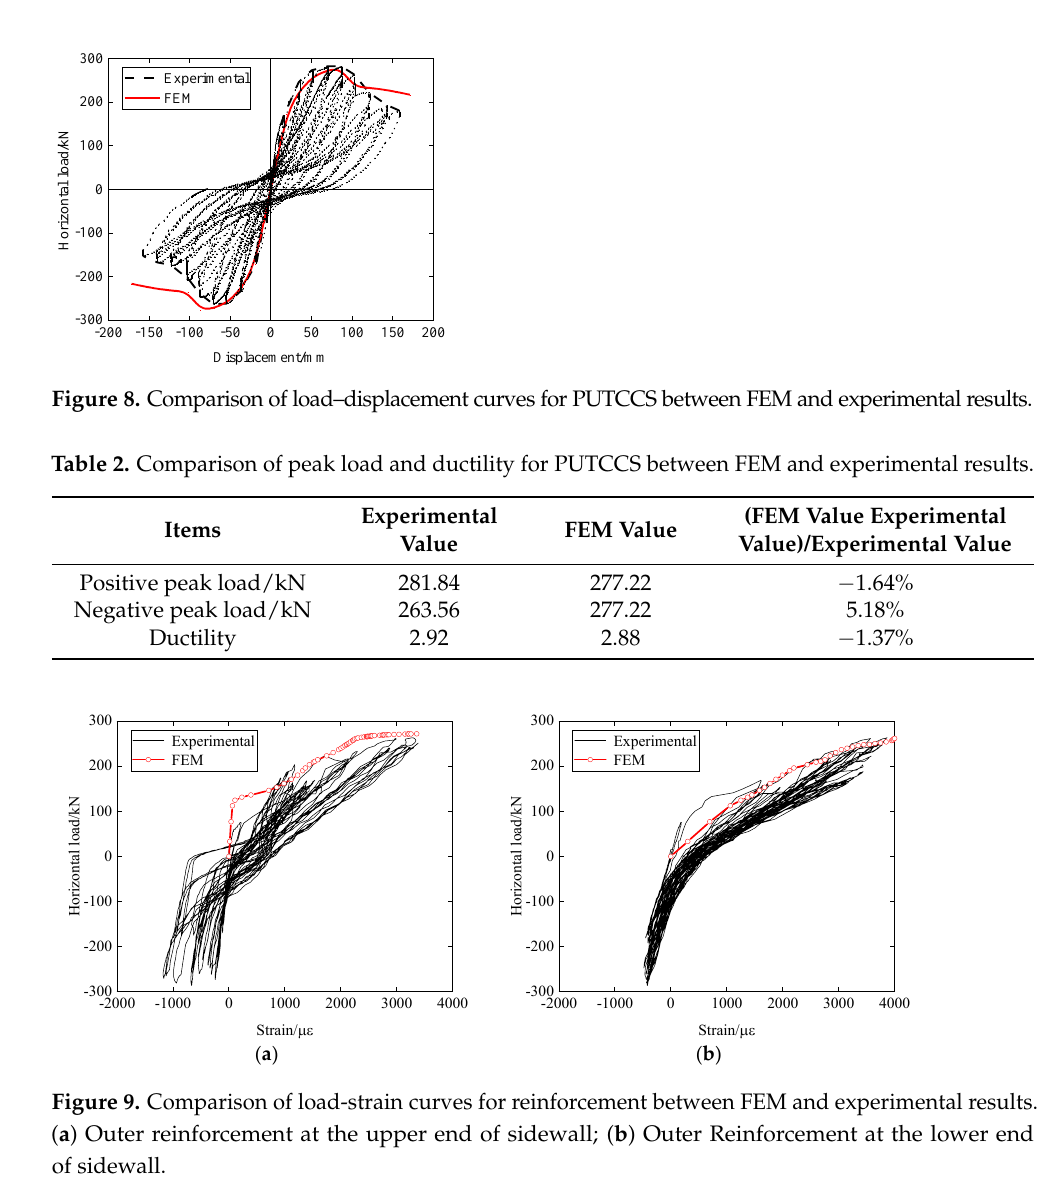
Figure 10. Method used to define yield and ultimate displacements. 4.1. Seam Location In order to study the effects of seam locations, four sets of seam locations are used for this investigation, which vary according to the vertical distance between the top of the haunch (for the bottom slab) and the seam. Such vertical distances are 0, 0.5, 1.0, and 1.5 times the wall thickness (300 mm), respectively, as shown in Table 3. The simulation results in terms of the horizontal load–displacement relationship are plotted in Figure 11, and the results in terms of values of the yield load, peak load, yield displacement, ultimate displacement, and ductility are shown in Table 3. It should be